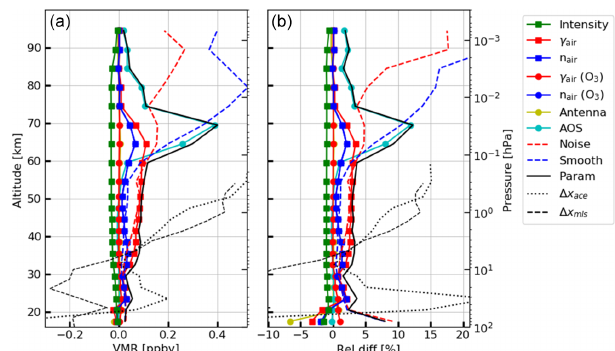
Figure 11. Summary of the errors for a single-scan observation. Panels (a) and (b) , respectively, show the absolute difference and relative difference, which were estimated using the perturbation method. The green marker indicates an error due to the uncertainty in line intensity (“intensity”). The red and blue squares show errors for the air-broadening coefficient (“ γ air ”) and its temperature depen- dence ( n air ) of the H 35 Cl transition. The red and blue circles show errors for “ γ air ” and n air of the O 3 transition (“ γ air (O 3 )”, “ n air (O 3 )”). The yellow and cyan symbols show errors for the antenna beam pattern (“antenna”), and the AOS response function (“AOS”). The dashed red and blue lines indicate E noise (“noise”) and E smooth (“smooth”), respectively. The solid black lines (“param”) indicate the total model parameter errors, obtained from the RSS of all the estimated parameter errors. The dotted and dashed black lines indicate the difference between SMILES and MLS, and between SMILES and